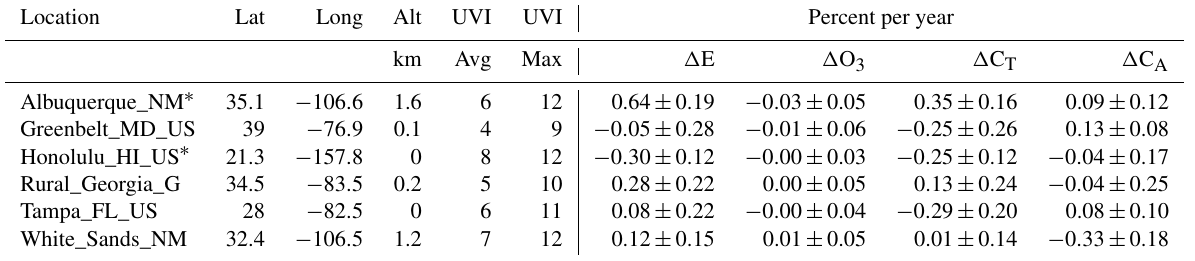
Table 2. Trends for locations in the United States (errors are 1 σ ).